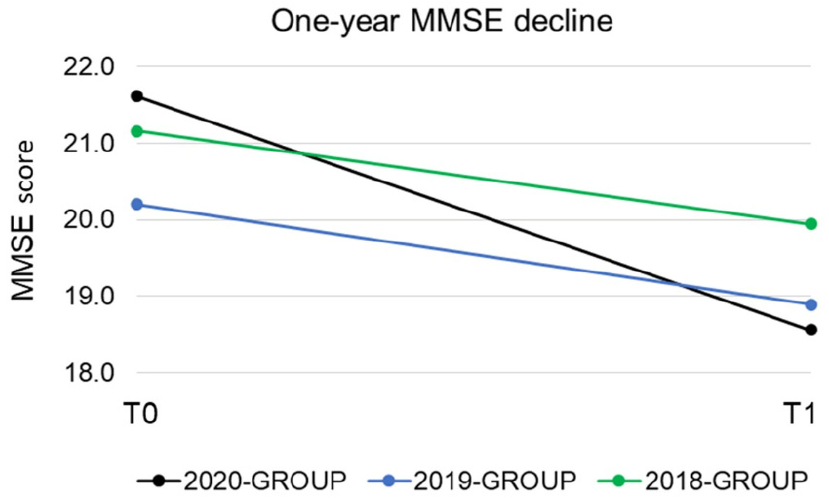
Figure 2. Annual mini mental state examination decline in the 2020-GROUP (black line), 2019-GROUP (blue line), and 2018-GROUP (green line). The 2020-GROUP showed a significantly higher loss of MMSE points per year, as calculated by the index of progression, than the 2019-GROUP and 2020-GROUP. MMSE: mini mental state examination.